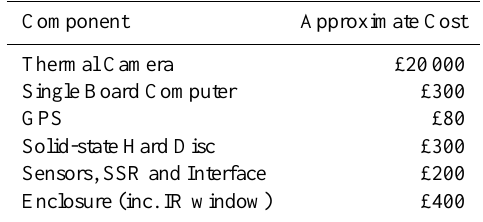
Table 1. Approximate cost breakdown of the thermal camera sys- tem.